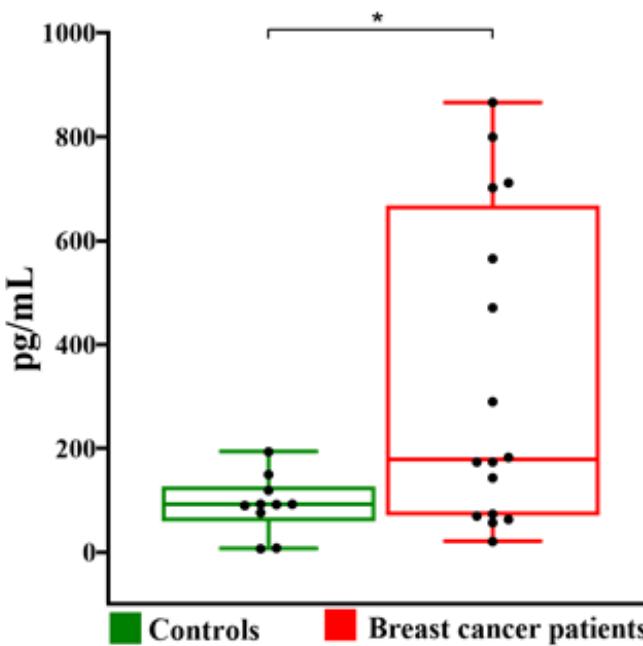
Figure 4. Boxplot representation of CXCL10 level in follicular fluids of control and BC patients. The box plots show medians and whiskers. Significance (* p < 0.05).